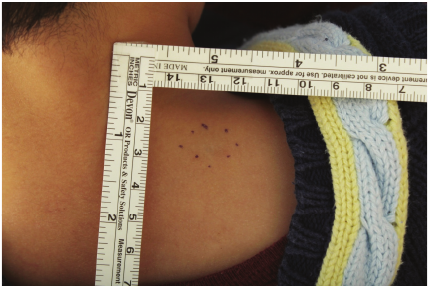
Figure 1: Clinical photography of a lesion shows a solitary cyst in the left posterior neck region, 1cm diameter.